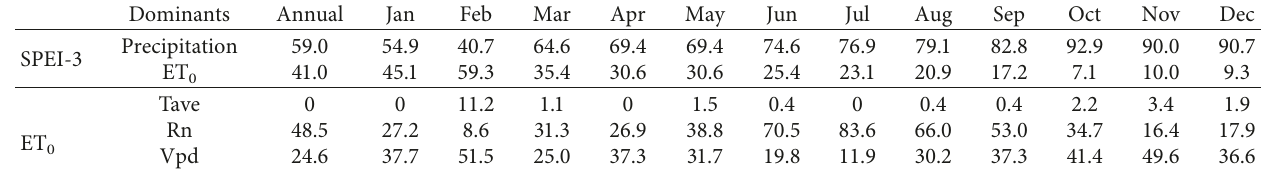
Table 3: Site percentage (%) with dominants of changed SPEI-3/ET